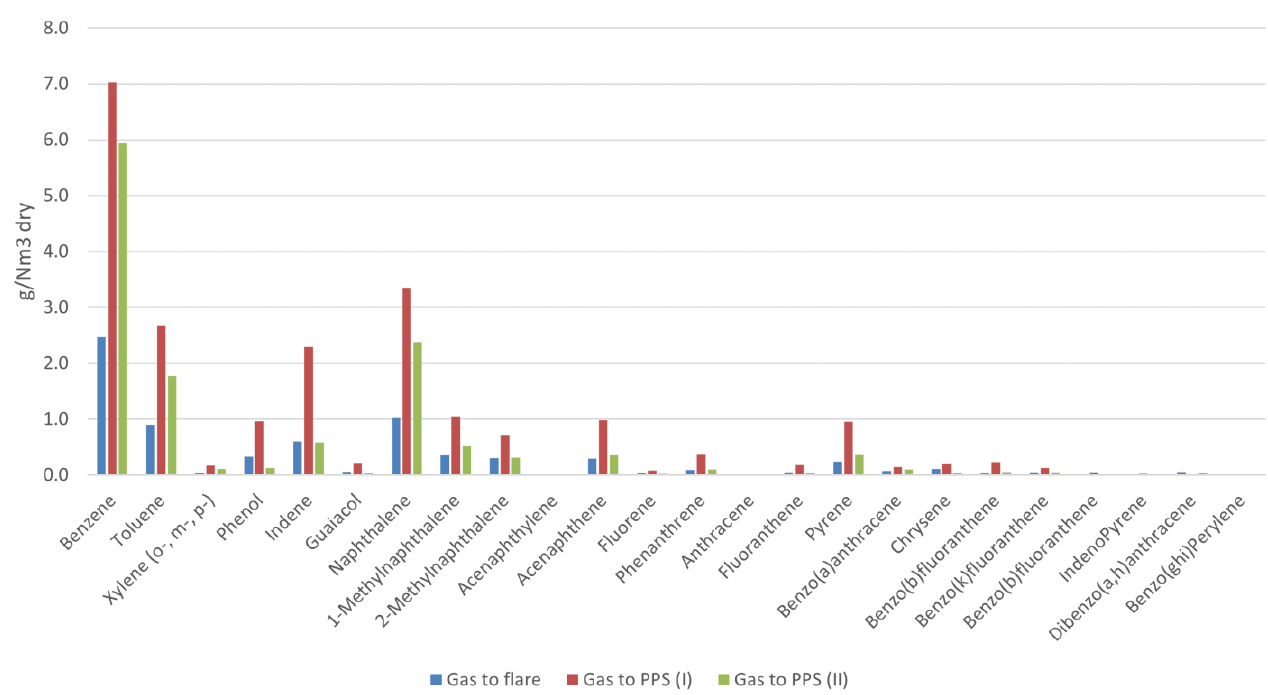
Figure 6. Distribution in the main tar molecules as observed via GCMS analysis.